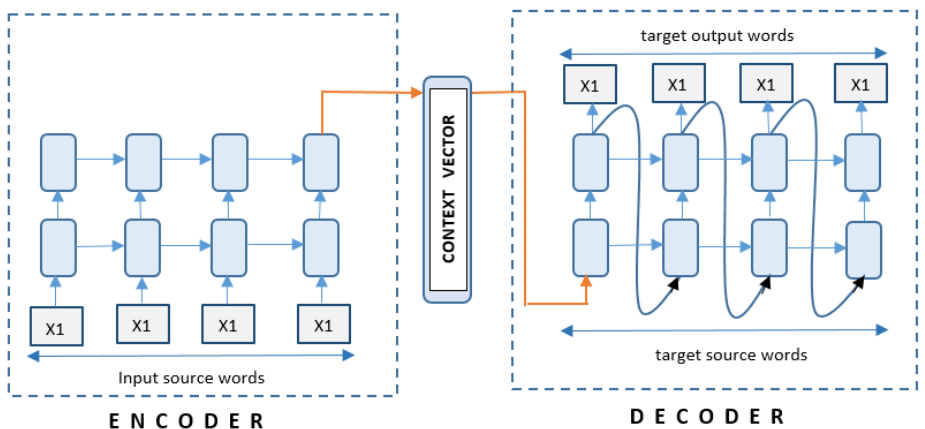
Figure 5. Basic encoder–decoder framework. Encoder